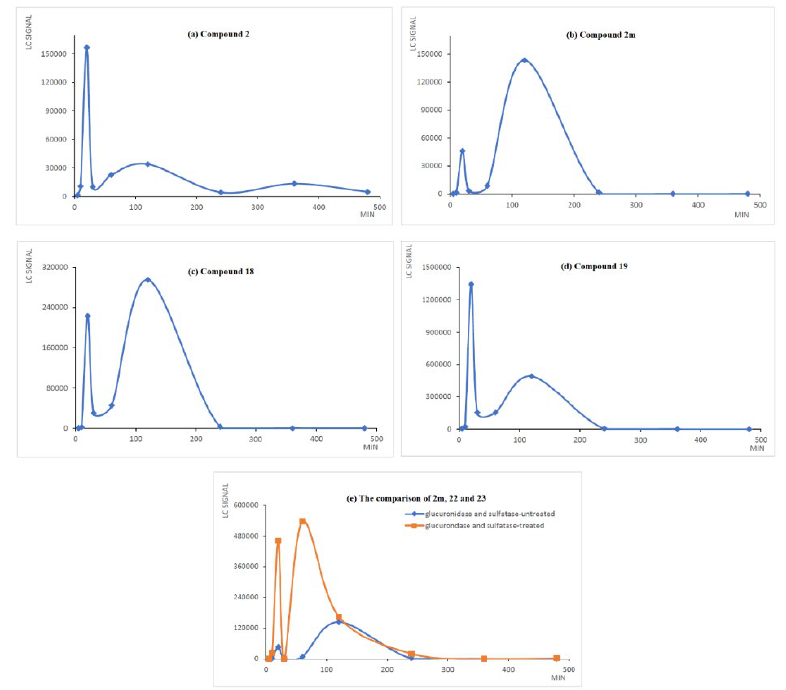
Figure 1. The amount of 2 , 2m , 18 , 19 , 22 , and 23 in serum at different time points following a single oral administration of 2 at a dose of 100 mg/kg. The blood samples were collected at 5, 10, 20, 30, 60, 120, 240, 360, and 480 min after the administration of 2 . The samples were deproteinated and analyzed by HPLC.